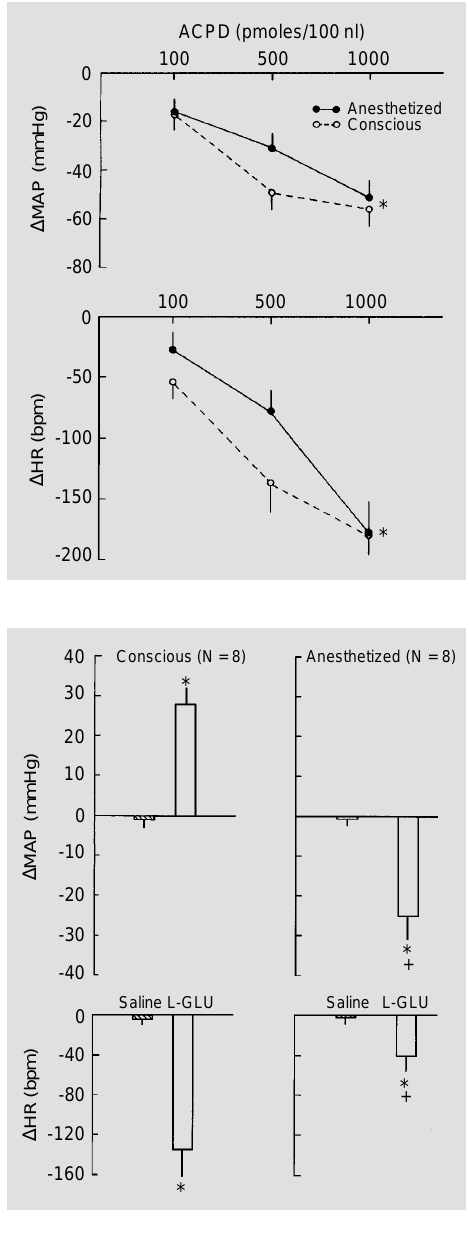
Figure 3 - Dose-dependent changes in mean arterial pres- sure ( D MAP, upper panel) and heart rate ( D HR, bottom panel) in response to increasing doses of trans-(±)-1-amino-1,3-cyclo- pentanedicarboxylic acid (ACPD; 100, 500 and 1000 pmol/100 nl) microinjected into the NTS of the same rats (N = 8) under con- scious (broken line) and anesthe- tized conditions (full line). Aster- isks indicate that trans-(±)-ACPD produced a dose-dependent re- duction in MAP and HR in con- scious and anesthetized rats (ANOVA, P<0.05). The changes in MAP and HR produced by each dose of ACPD into the NTS of conscious or anesthetized rats were not statistically different (*P<0.05, paired t-test).